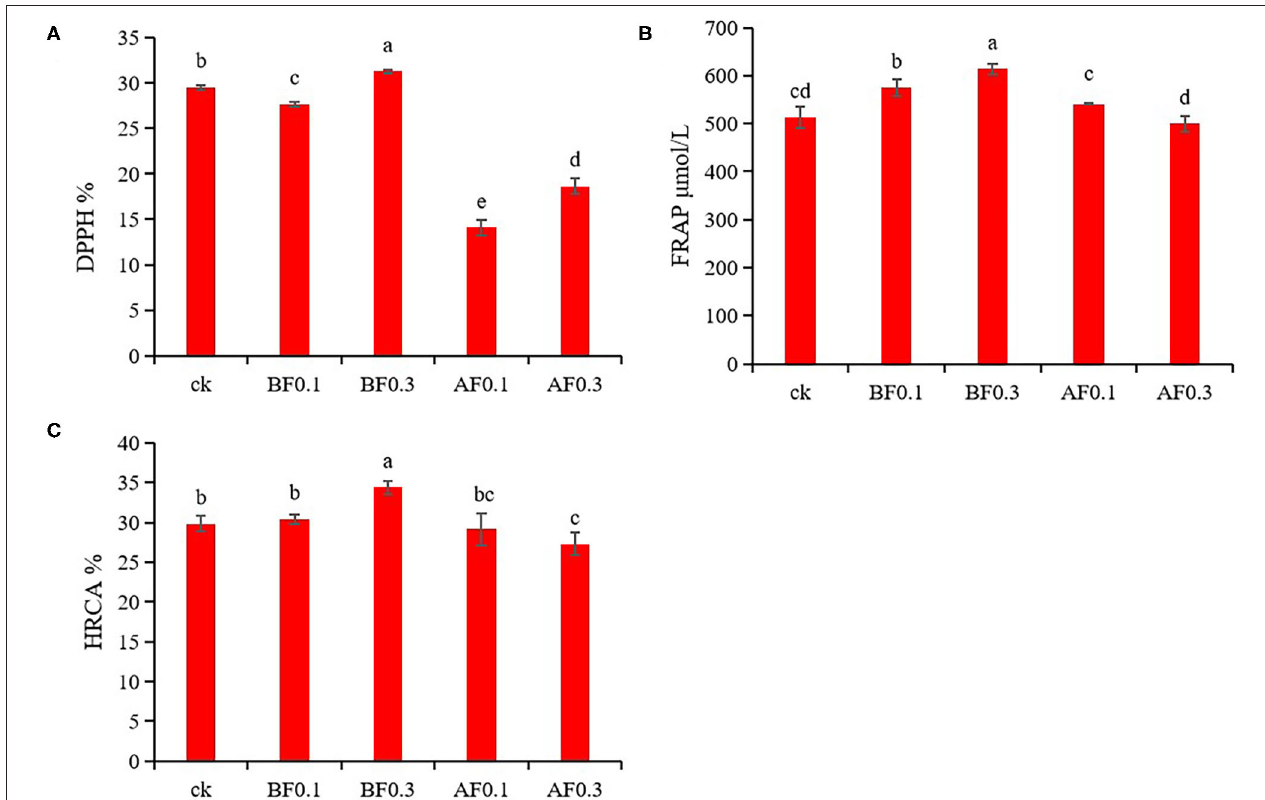
FIGURE 2 | Effect of mannoprotein concentration on the antioxidant capacity of wine. (A) : 1,1-diphenyl-2-picrylhydrazyl (DPPH), (B) : ferric reducing antioxidant power (FRAP), (C) : hydroxyl radical scavenging ability (HRCA). Values presented are means ± SD ( n = 3). Different letters indicate significant differences among treatments using Duncan test ( p < 0.05). CK: control group with 0 g/L MP, BF0.1: 0.1 g/L mannoprotein addition before fermentation, BF0.3: 0.3 g/L mannoprotein addition before fermentation, AF0.1: 0.1 g/L mannoprotein addition after fermentation, BF0.3: 0.3 g/L mannoprotein addition after